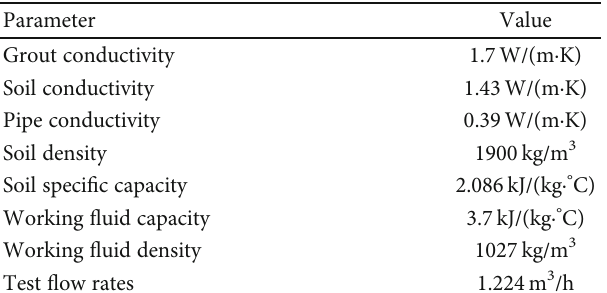
Table 3: Experimental parameters of the GHEs.